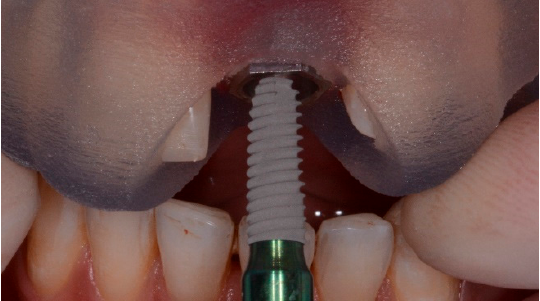
Figure 1. Surgical templates with metallic sleeves.